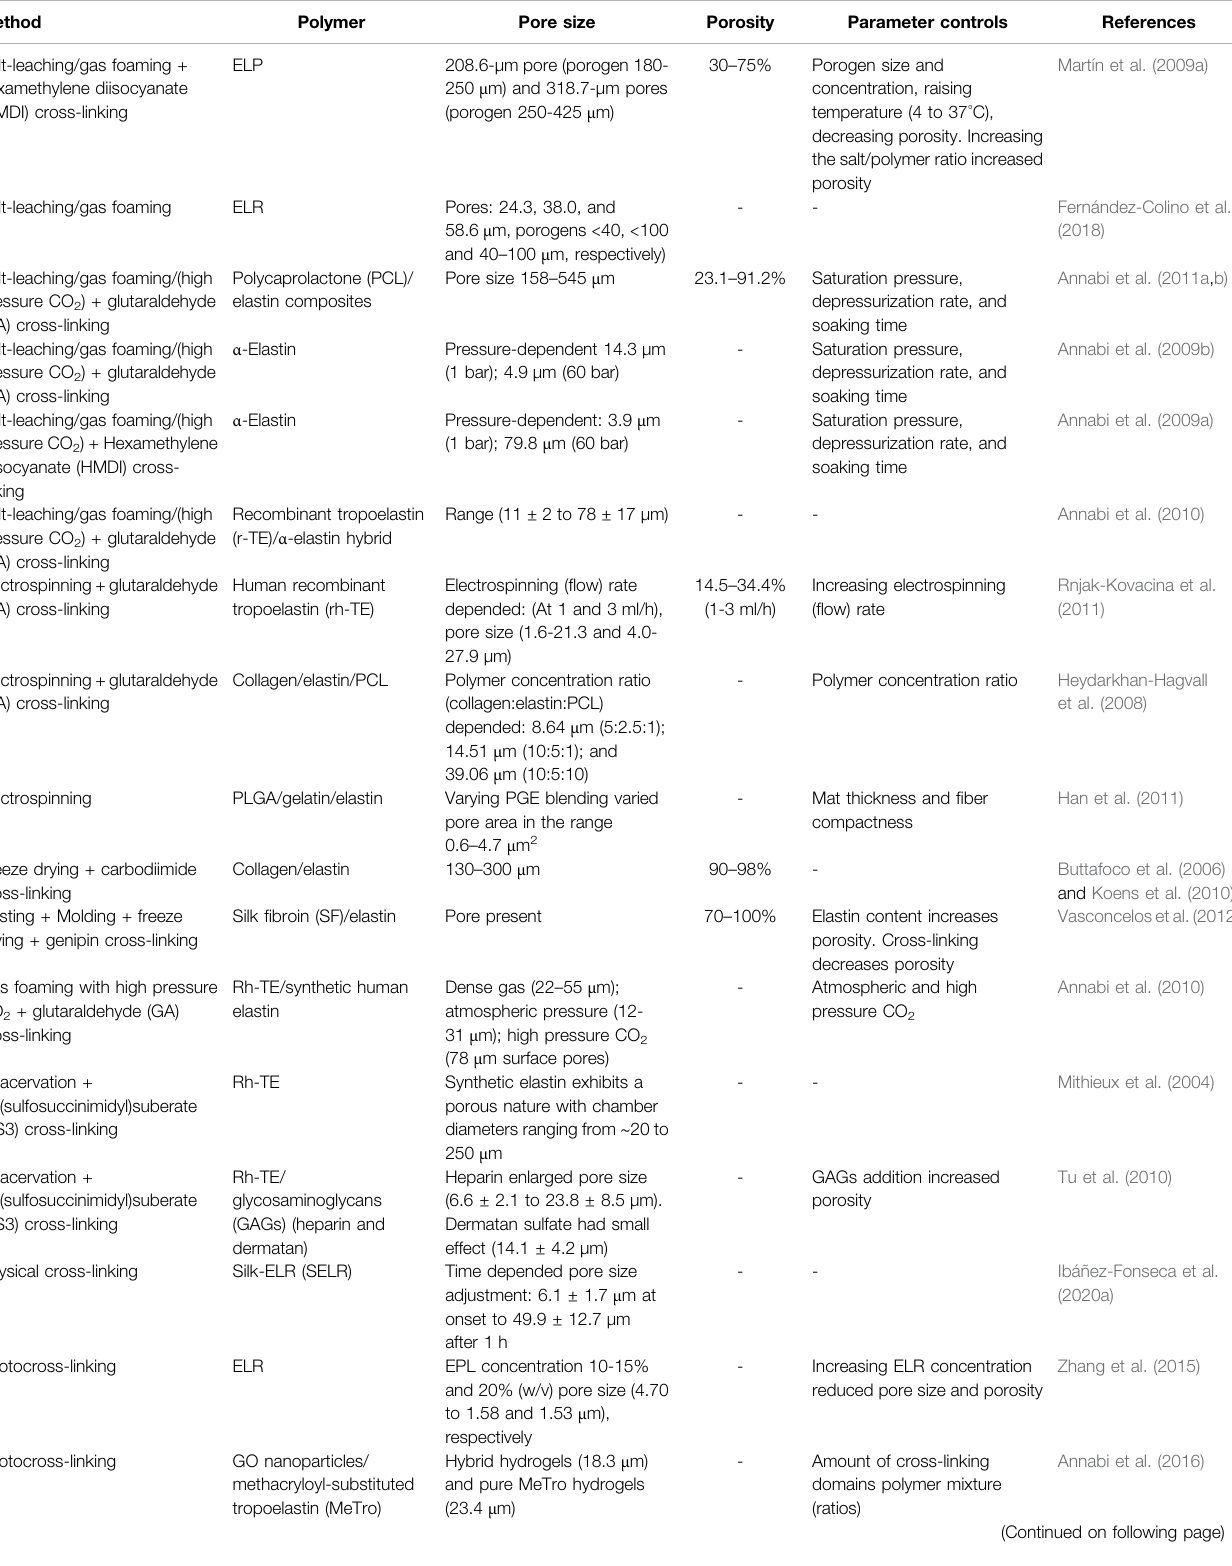
TABLE 1 | Representative examples of the production and parameter control of elastin and elastin-like polypeptide – based porous